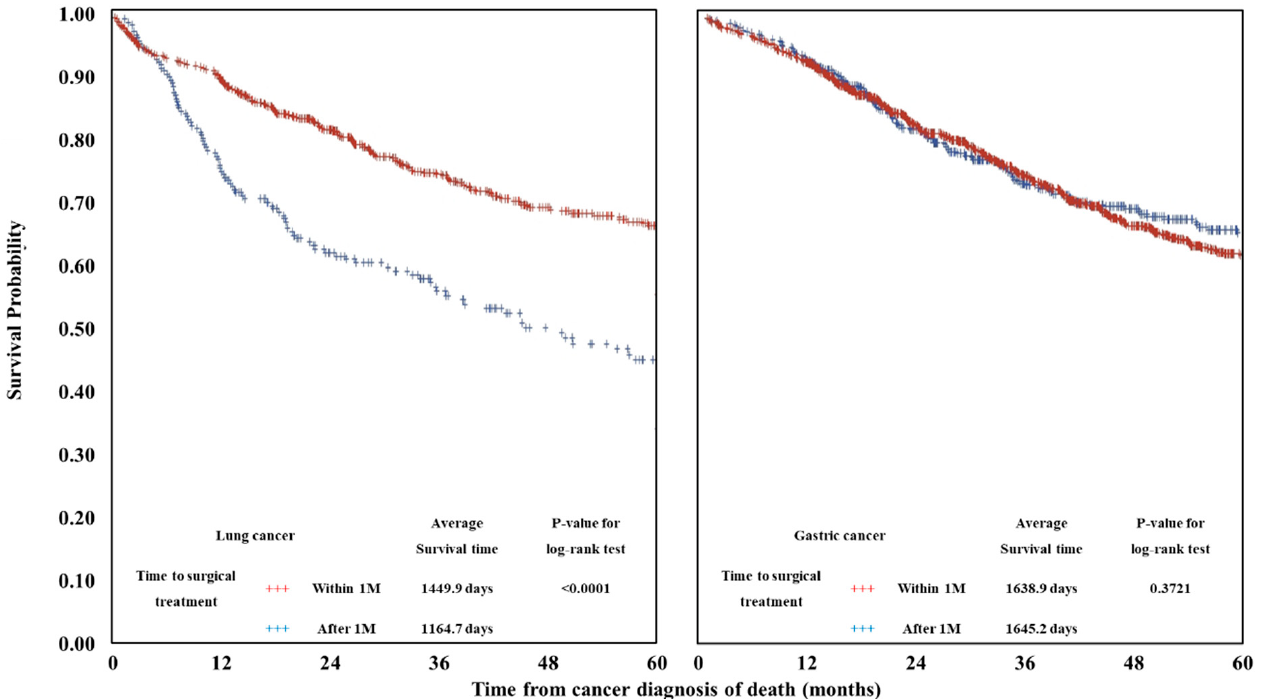
Figure 2. Survival curve and results of log rank test.